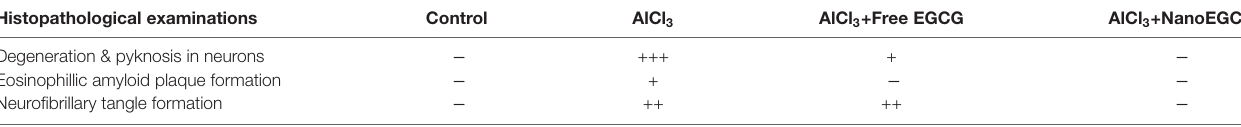
TABLE 1 | Effect of nanoparticles epigallocatechingallate (nanoEGCG) on the severity of histopathological alterations in the cortex of Alzheimeric rat brains.